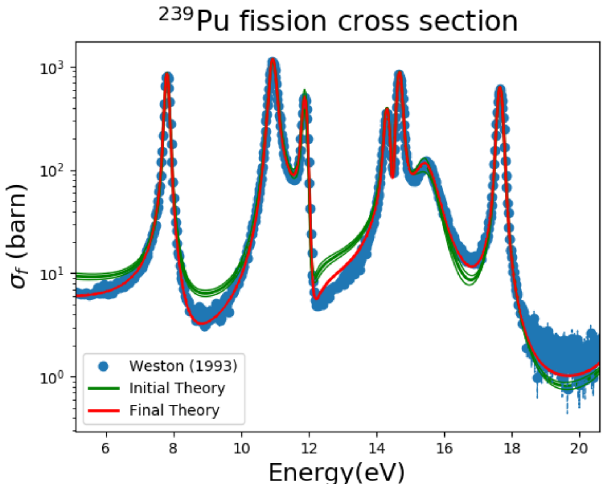
Fig. 11. 239 Pu resonance parameters adjustment on a fission cross section measurement. Theoretical/experimental compar- isons before an after